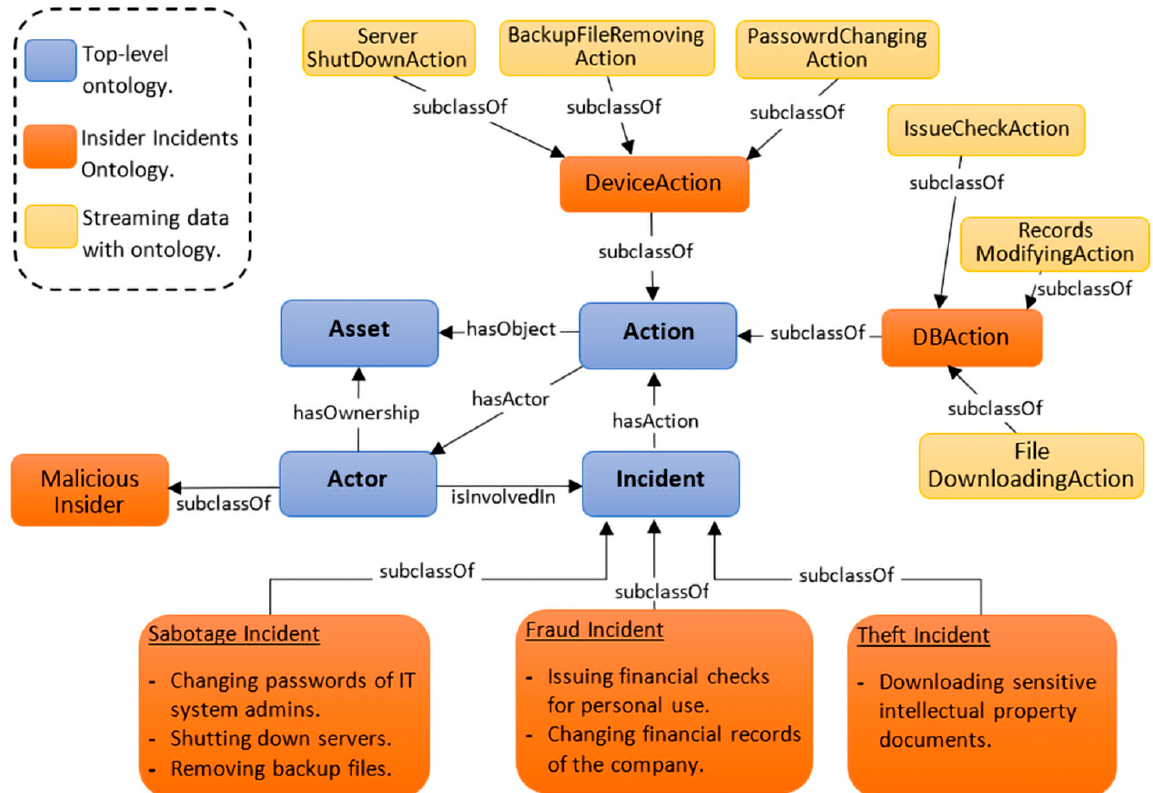
Figure 4. The framework ontology of the insider threat incidents.